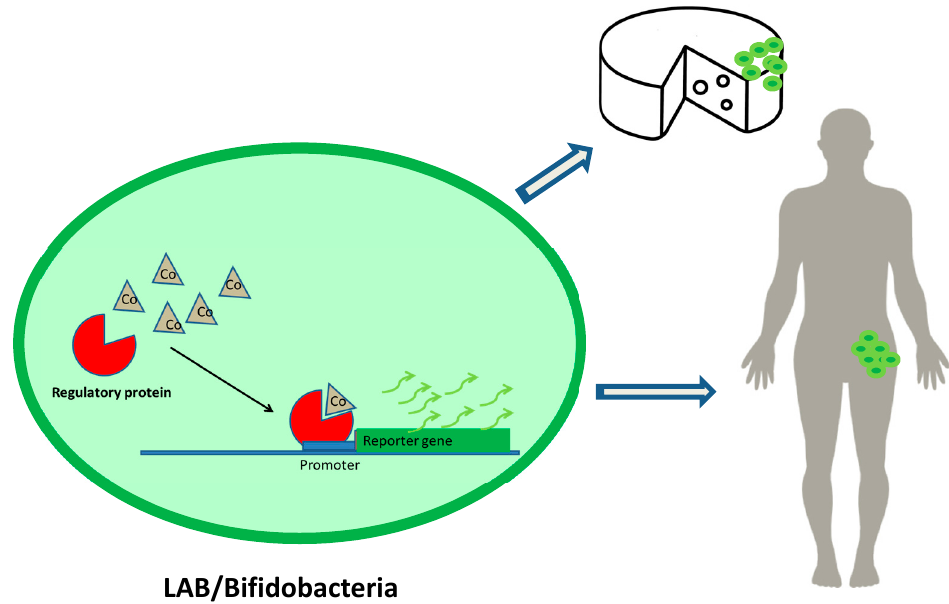
Figure 2. Detection of cobalt in food and living beings through the use of lactic acid bacteria (LAB) or bifidobacteria as DNA microbial biosensor vehicles.